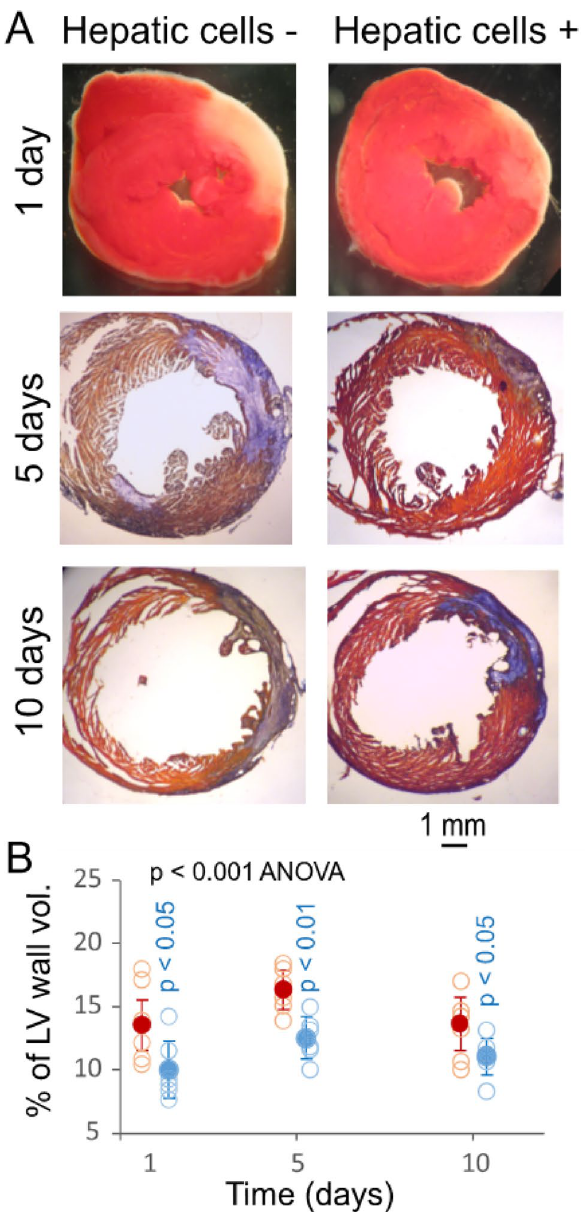
LV specimens at day 5 and 10 of MI-R were stained with orange red and methylene blue (AZAN assay) for demonstrating myocardial fibrosis (blue) in mice with and without hepatic cell transplantation. ( B ) Graphic representation of the influence of hepatic cell transplantation on the level of myocardial infarction. Solid red and blue circles: Means ± SDs from individual mice without and with hepatic cell transplantation, respectively. Open red and blue circles: Raw data points (n = 6) from individual mice without and with hepatic cell transplantation, respectively. The blue-colored p value at each time point is for comparison between mice with and without hepatic cell